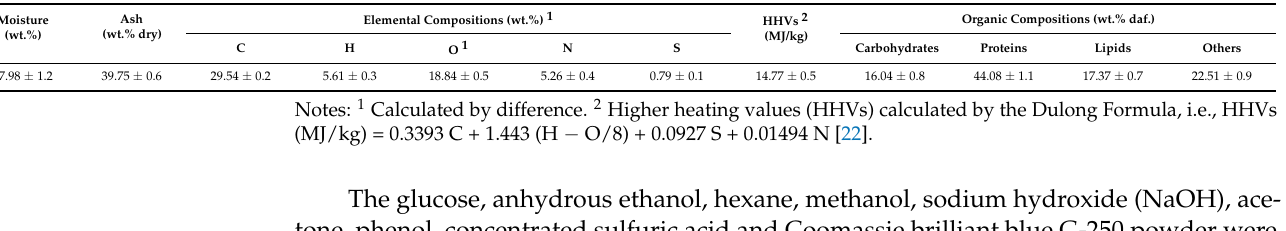
Table 1. Characteristics of raw